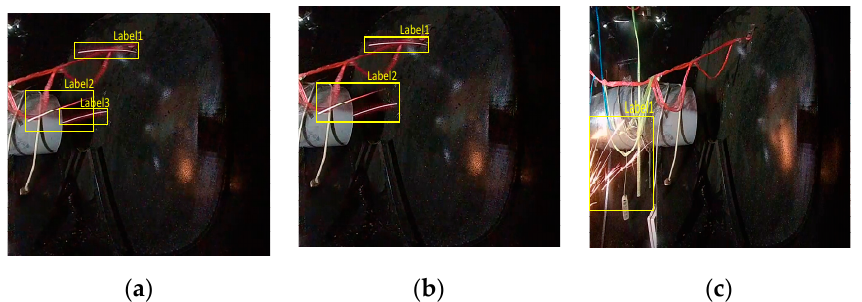
Figure 13. Images and visualization labels in the SAES data set: ( a , b ) two different correct labels corresponding to the same image, where the position of a single spark in the image can be correctly described by label 1 in ( a ) and in ( b ); however, the two close sparks corresponding to labels 2 and 3 in ( a ) can also be correctly described by label 2 in ( b , c ) A cluster of sparks and its corresponding label.